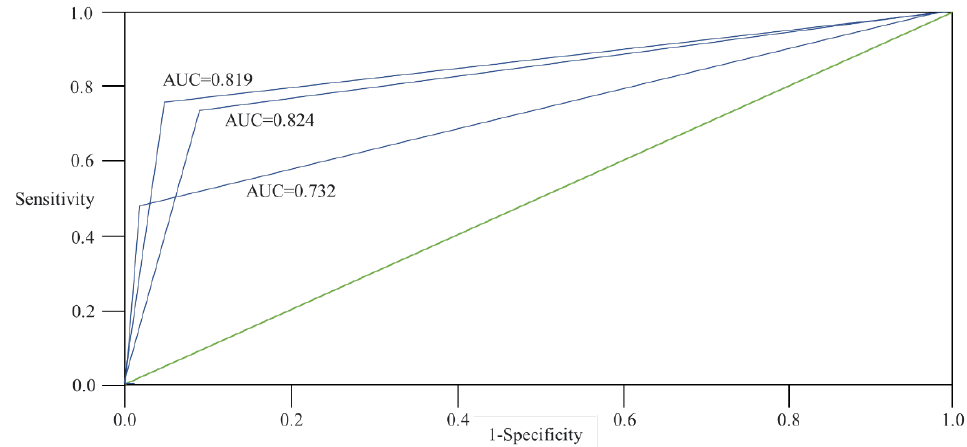
Figure 4. Receiver operating characteristic curve, discriminant analysis, logistic regression analysis,